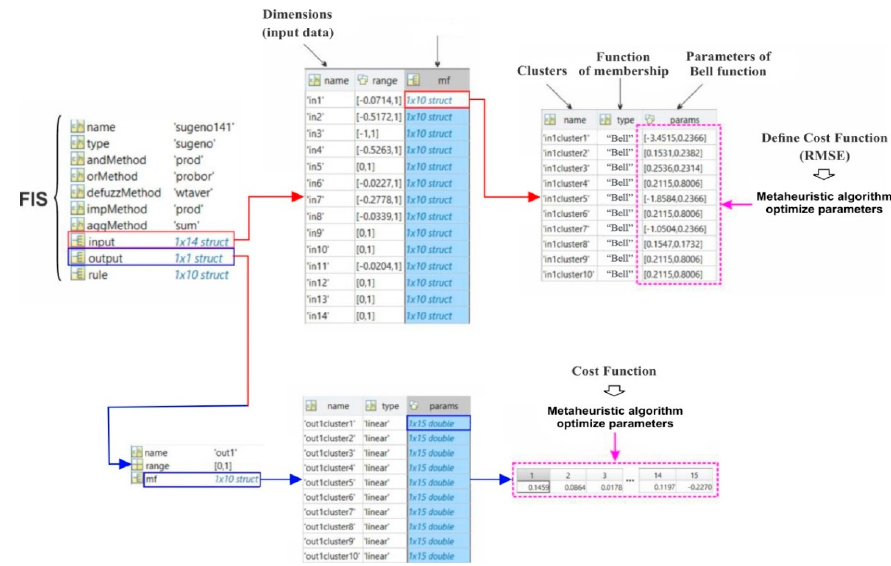
Figure 5. Flowchart of modelling process in this study.